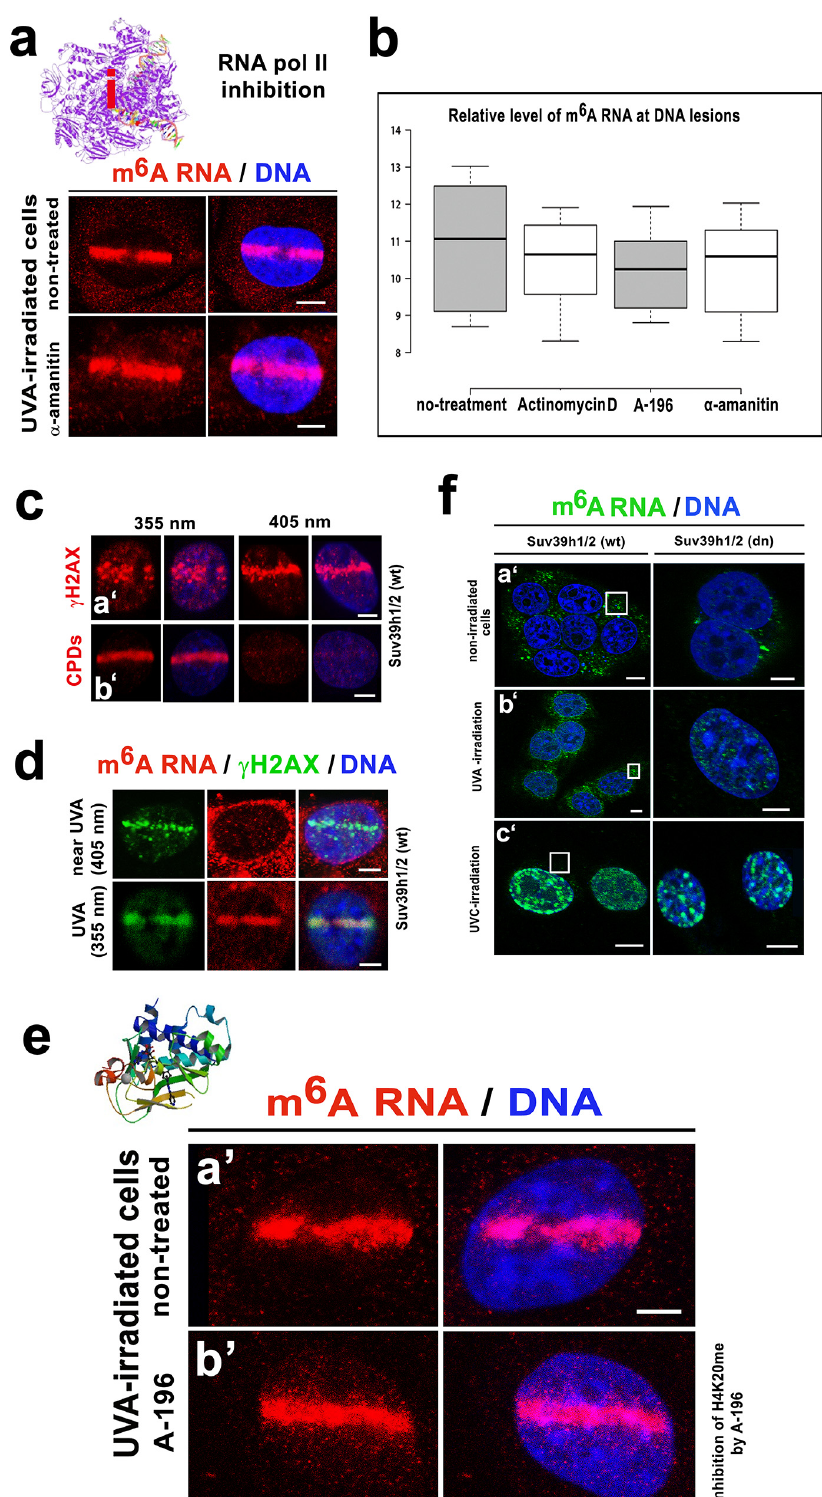
Figure 4. m 6 A RNAs were present at only CPD-positive chromatin, and inhibitors of RNA pol I and RNA pol II did not a ff ect the m 6 A RNA level in the microirradiated regions. ( a ) An inhibitor of RNA pol II, α -amanitin, did not a ff ect m 6 A RNA levels at the DNA lesions. For an illustration of RNA pol II inhibition (red i), the RNA pol II elongation complex was adapted from the PDB database [51]. ( b ) Summary of the inhibitory e ff ects (treatment by actinomycin D, A-196, and α -amanitin) on m 6 A